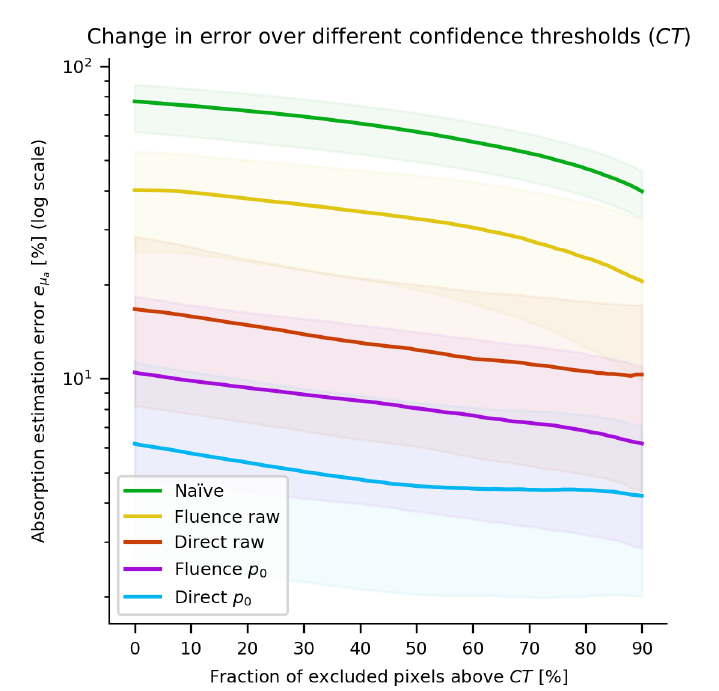
Figure 5. Quantification error as a function of the confidence threshold ( CT ) for five different quantification methods. The line shows the median relative absorption estimation error when only evaluating with the most confident estimates regarding CT , and the transparent background shows the corresponding interquartile range. Naïve: Fluence correction with a homogeneous fluence estimate; Fluence raw/ p 0 : Deep learning-based quantification of the fluence applied to p 0 and raw time-series input data and subsequent estimation of µ a ; Direct raw/ p 0 : End-to-end deep learning-based quantification of µ a applied to p 0 and raw time-series input